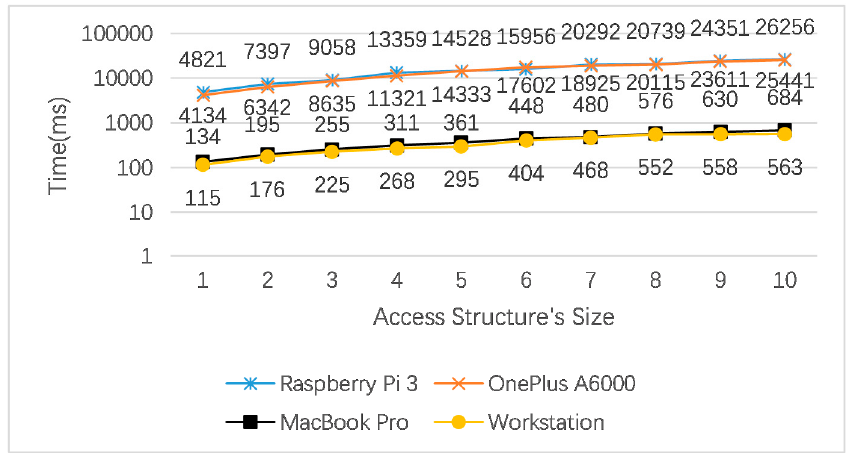
Figure 11. Performance of hybrid ABE decryption (1 KB plaintext).